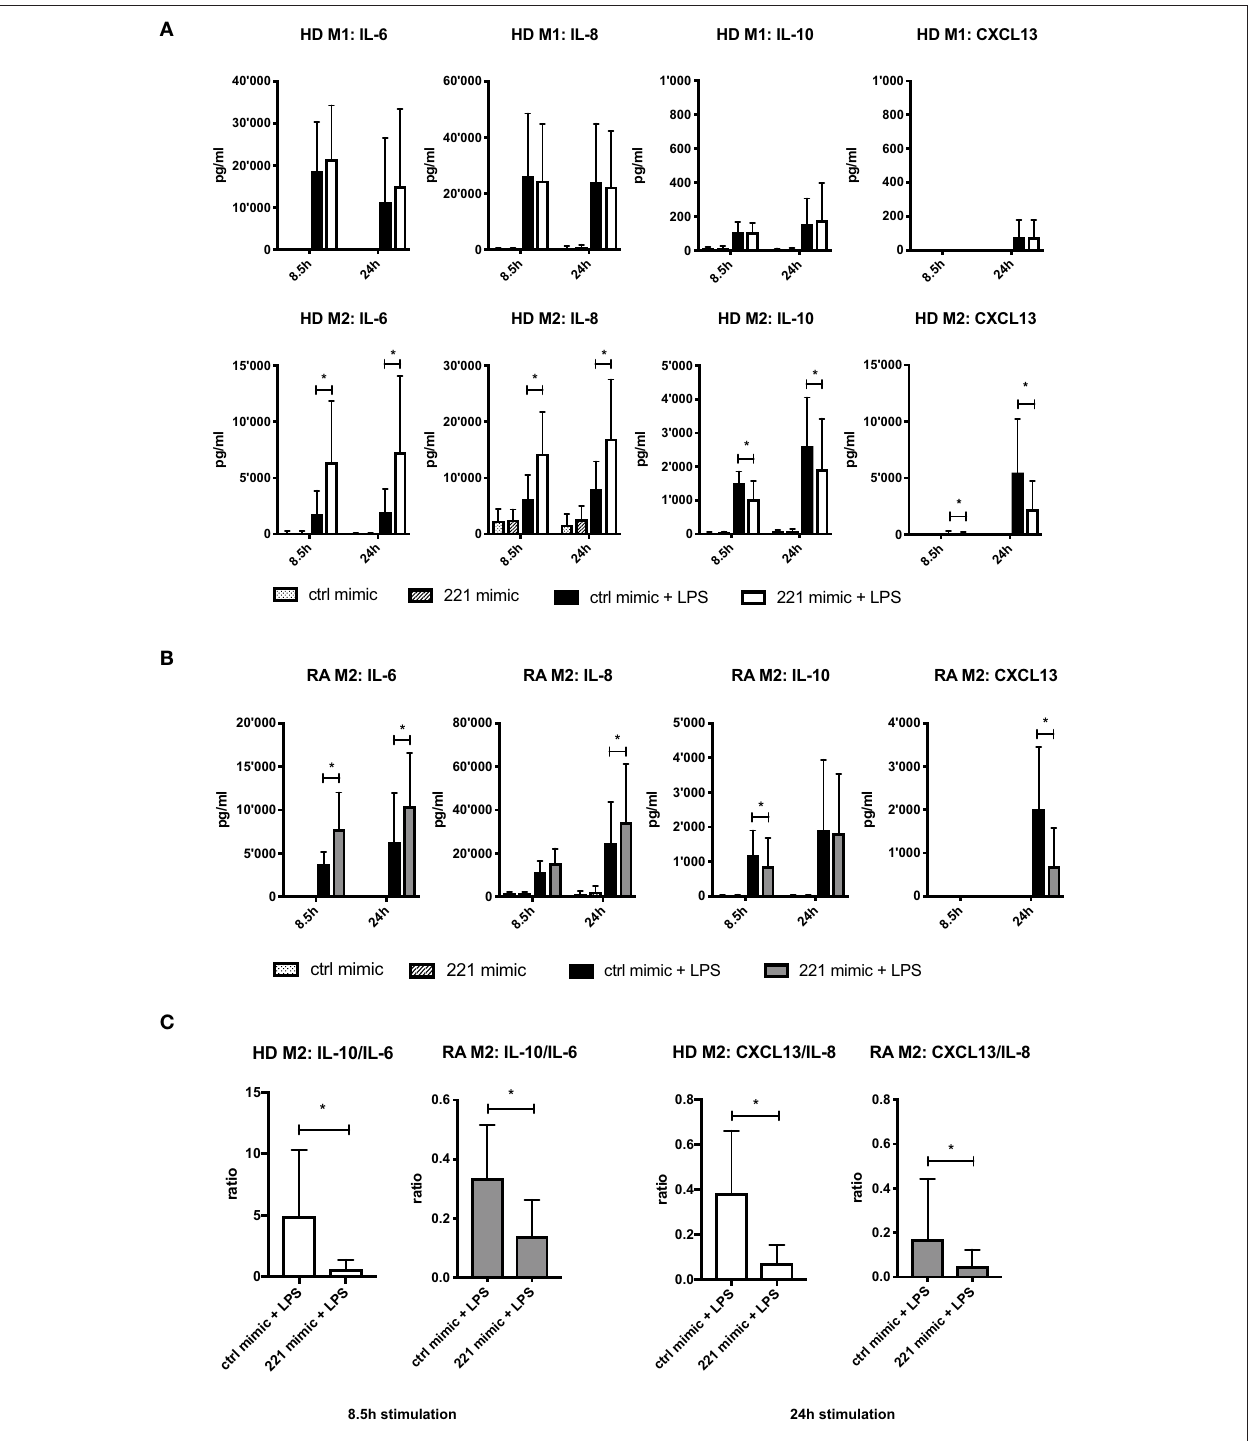
FIGURE 4 | Effects of miR-221-3 p mimics on cytokine and chemokine release in M1- and M2-macrophages. (A) M1- and M2-macrophages differentiated from CD14 + cells from HD blood were transfected with mimic of miR-221-3 p (221 mimic) or a respective control miR (ctrl mimic) and stimulated with 100ng/ml LPS or left untreated. Secreted cytokines and chemokines were measured after 8.5 and 24h by ELISA and values are expressed as mean ± S.D. N = 6–10, * p < 0.05. (B) M2-macrophages differentiated from CD14 + cells from blood of RA patients were transfected with mimic of miR-221-3 p (221 mimic) or a respective control miR (ctrl mimic) and stimulated with 100ng/ml LPS or left untreated. Secreted cytokines and chemokines were measured after 8.5 and 24h by ELISA and values are expressed as mean ± S.D. N = 6–11, * p < 0.05. (C) Anti-inflammatory activity of generated M2-macrophages from HD or RA patients was calculated after 8.5 and 24h LPS-stimulation by the ratio of secreted cytokines IL-10 to IL-6 or chemokines CXCL13 to IL-8. Values are expressed as mean ± S.D. N = 6–11, * p < 0.05.